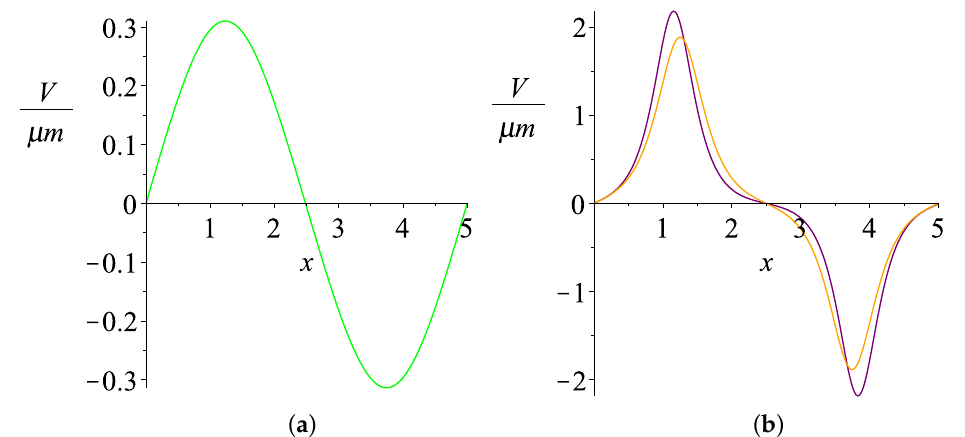
β α (green curve) corresponding to the propaga- P